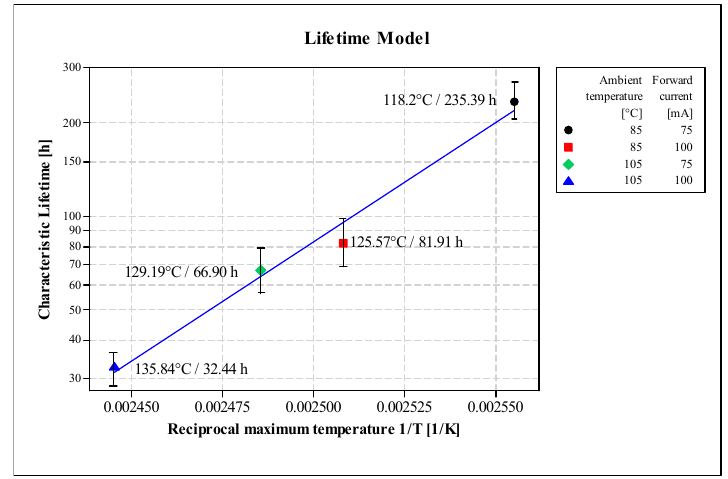
Figure 22. Proposed lifetime model, including 95% lower and upper confidence intervals equation. Equation: y = 5·10 − 5 ·e 17676x ; R 2 = 0.9846.